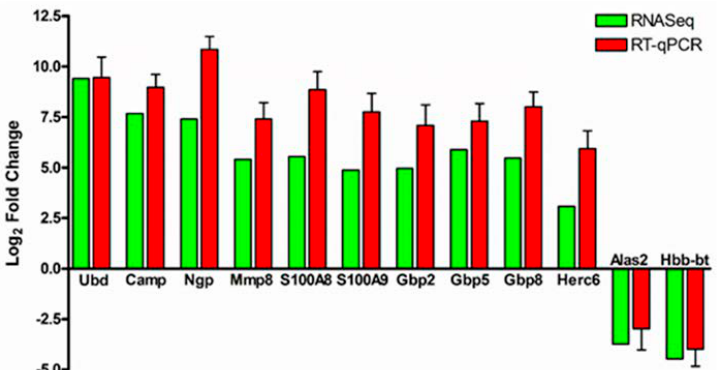
Figure 1. Validation of RNA-seq data by real time quantitative PCR (RT-qPCR). Total RNA from the lungs of mock-infected controls and Rickettsia conorii -infected mice was extracted by Tri-reagent, DNaseI treated, and reverse transcribed. Quantitative RT-PCR was performed using gene-specific primers and 18S rRNA as the endogenous control. Gene expression observed in RNA-seq data sets are presented as mean, and RT-qPCR as the mean ± standard error of the mean (SEM). The fold change observed in RT-qPCR is in accordance with that observed in RNA-seq